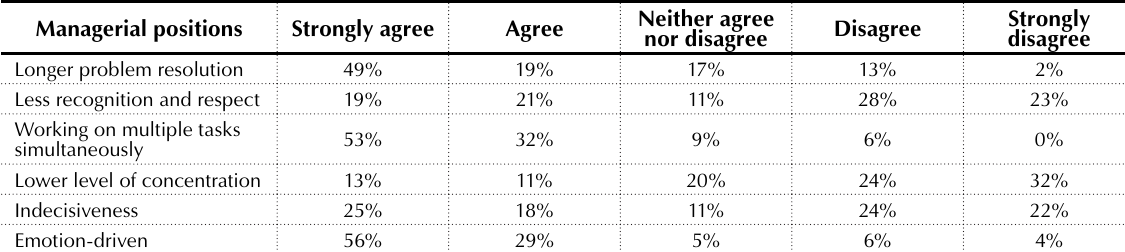
Source: elaborated by authors based on research